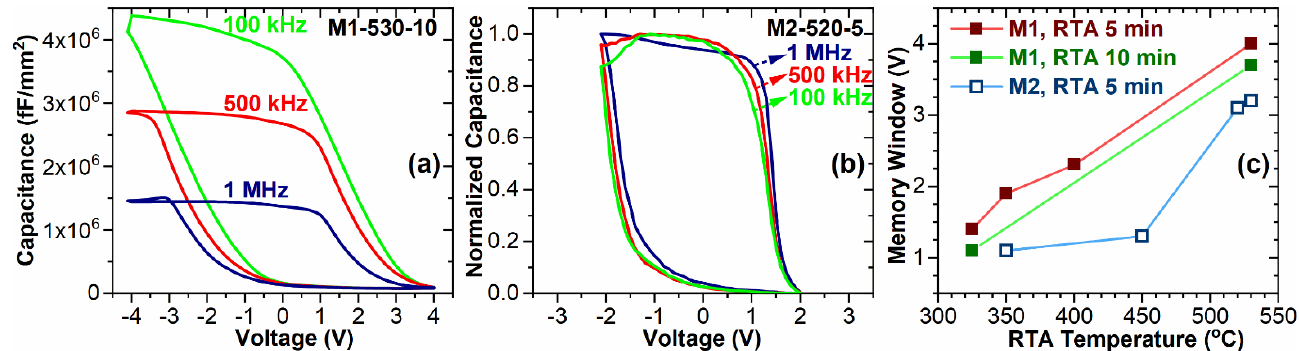
Figure 5. C – V results: ( a , b ) C – V hysteresis loops measured at frequencies of 100 and 500 kHz, and 1 MHz on structures M1-530-10 (absolute measured values expressed in terms of device’s area, e.g., capacitance/area unity) and M2-520-5 (normalized curves for evidencing the frequency-independent memory window; the maximum capacitance at 1 MHz is 1.3 nF equivalent to 1.3 × 10 6 fF/mm 2 ); ( c ) memory window ∆ V fb in function of RTA temperature for different structures annealed for 5 min (M1 and M2) and 10 min (M1). Table 2. Memory window ∆ V FB and stored electron density n .